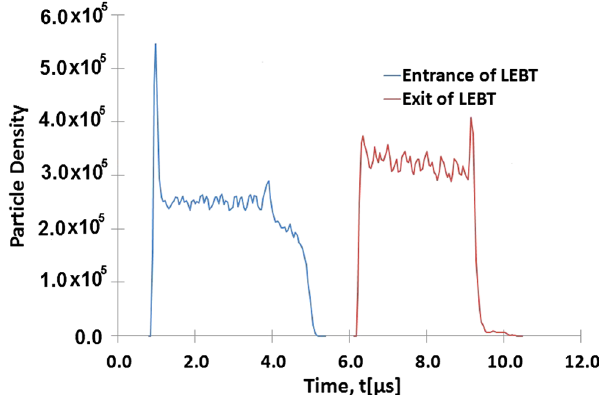
FIG. 29. Distribution of macroparticles in time at the entrance and at the end of the LEBT region.